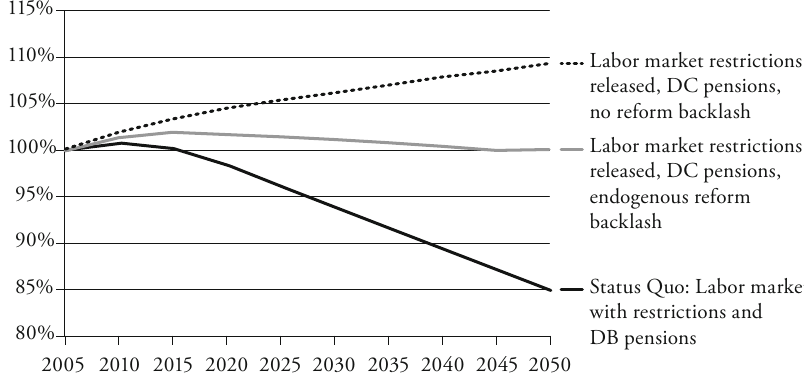
Figure 4: Policy Adaptation Mechanisms: Labor Market, Pension and no